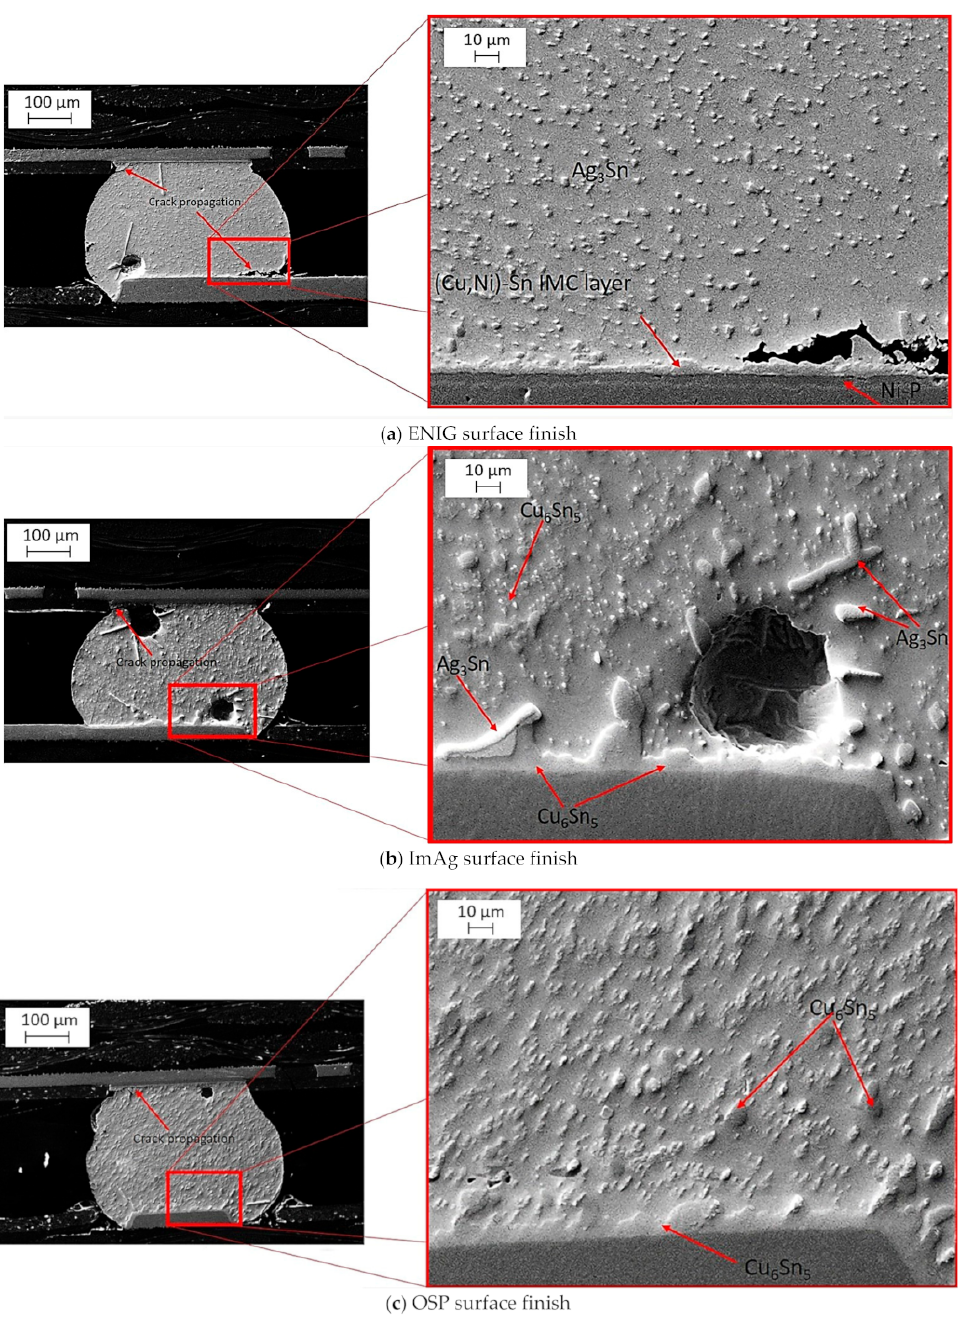
Figure 14. SEM image of SAC-Bi alloy with ( a ) ENIG; ( b ) ImAg; and ( c ) OSP surface